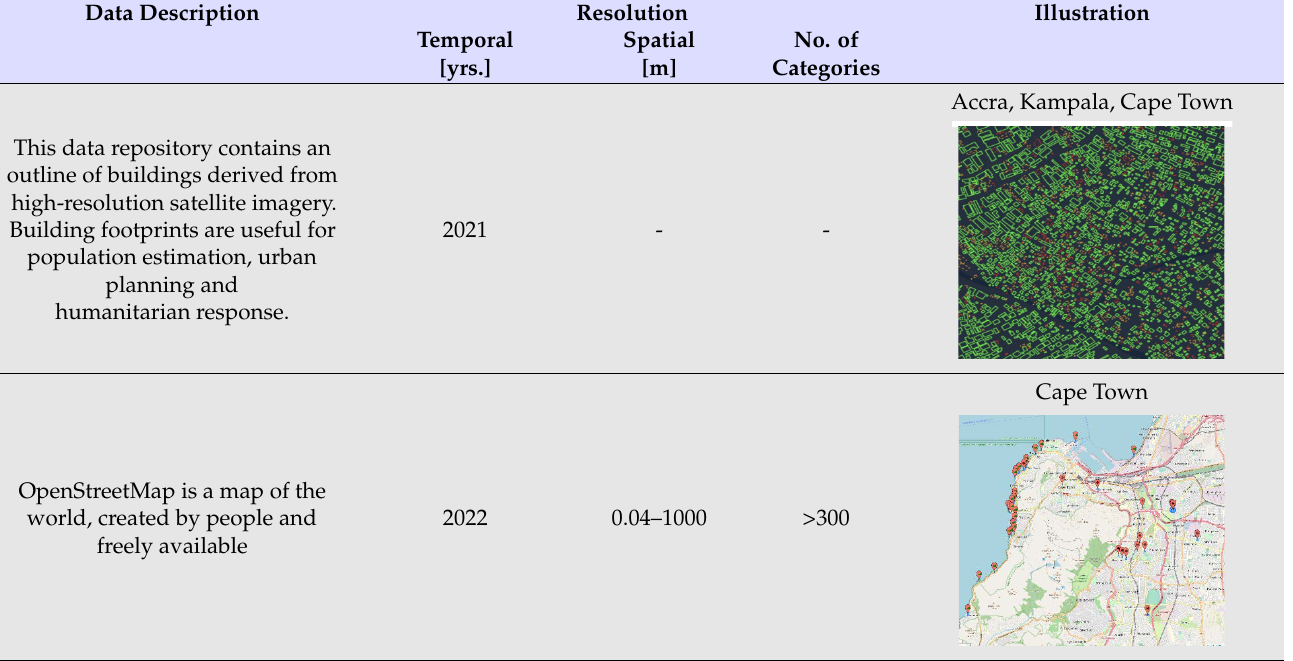
Table 3. EO dataset revealing optional dataset for exploring environmental